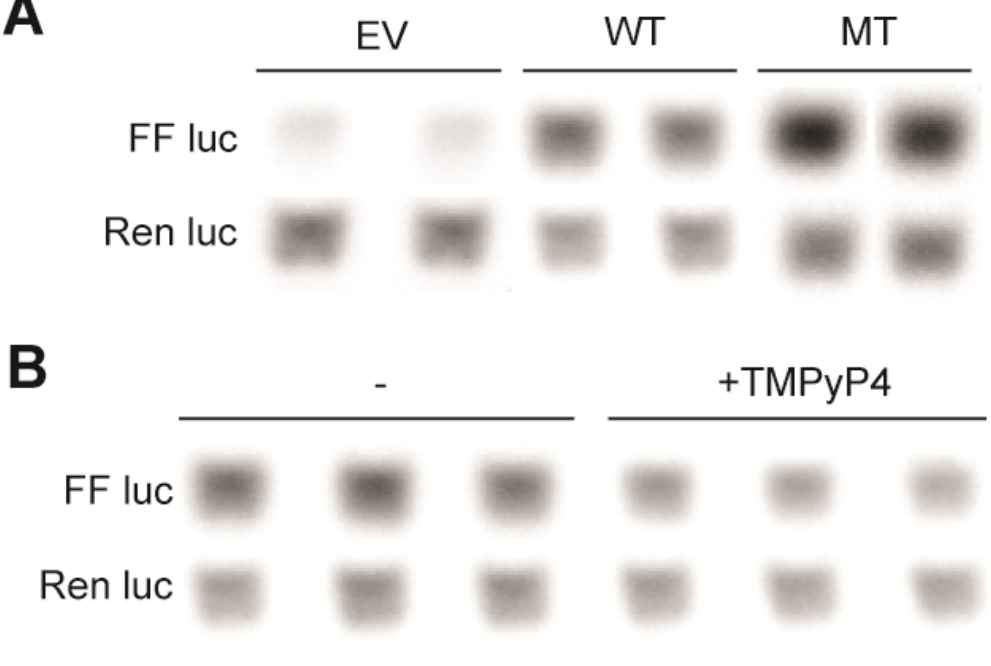
Figure 3 . Real-time PCR of firefly and renilla luciferase from ADAM-15